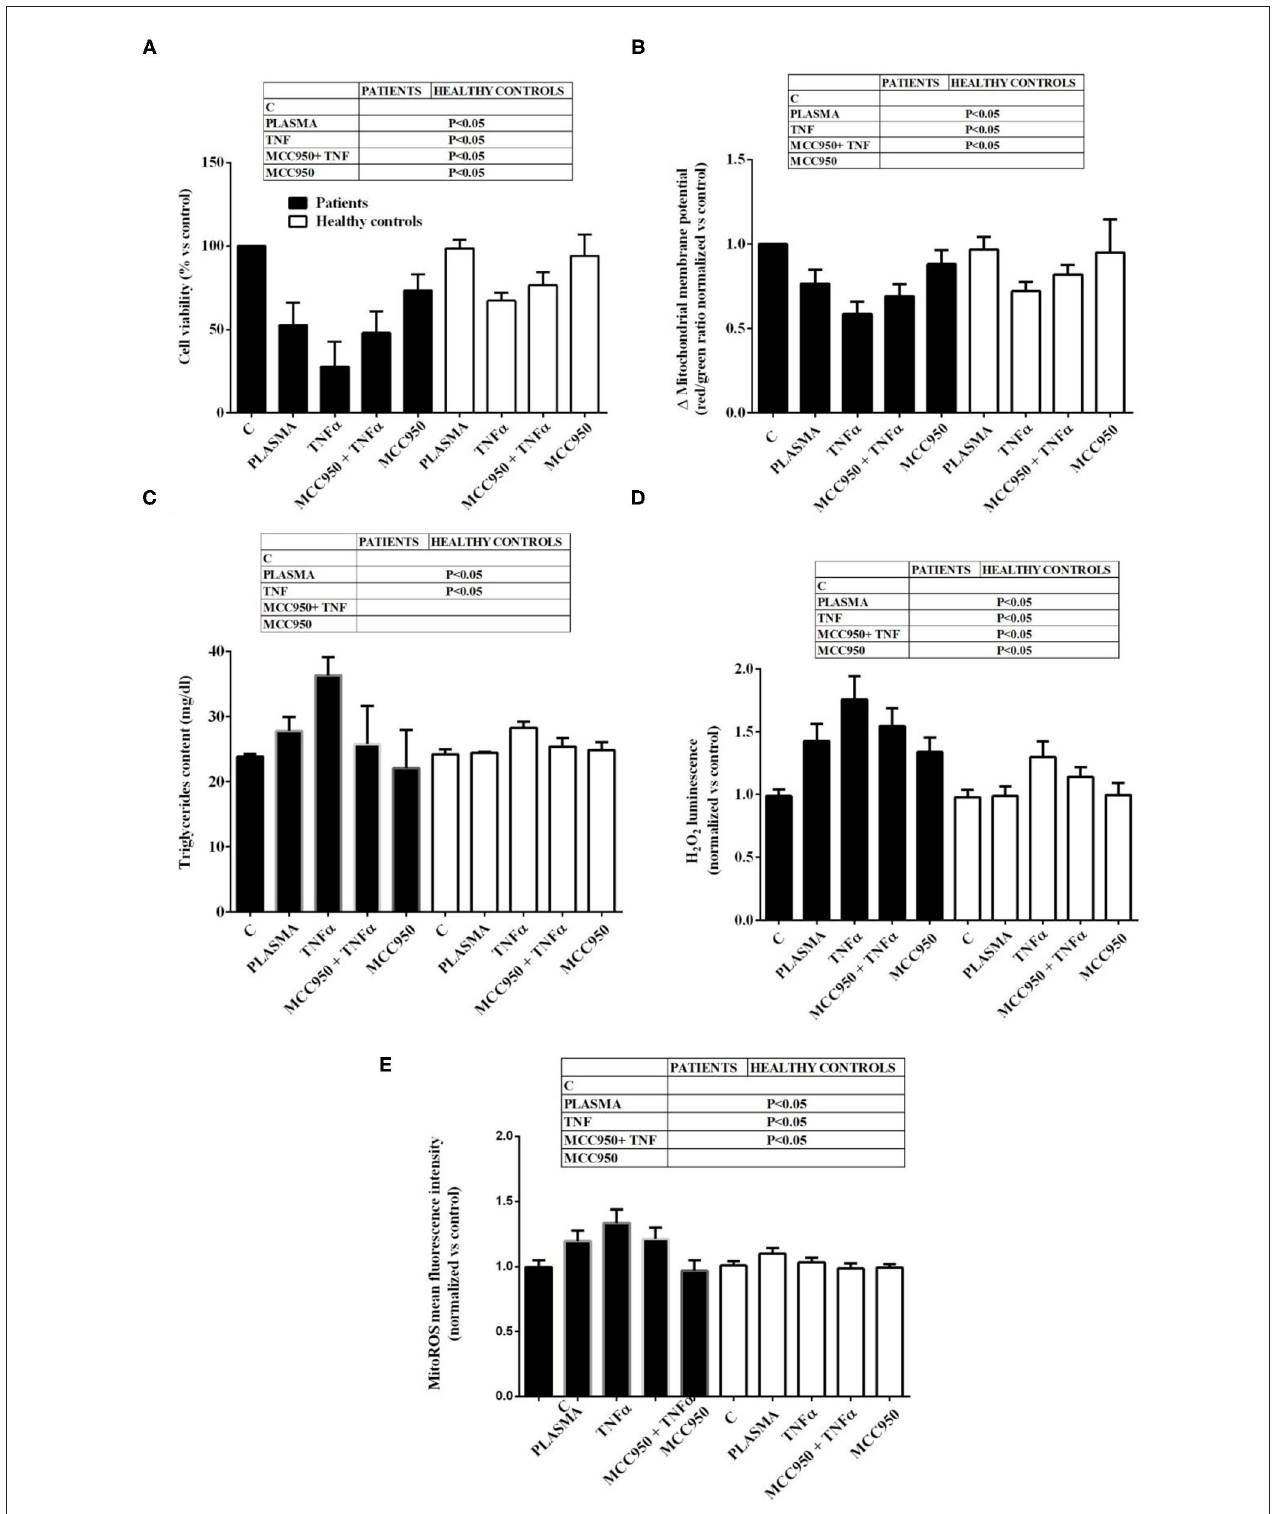
FIGURE 2 | Comparison between the effects of NAFLD plasma and of plasma from healthy subjects on Huh7.5 cell viability (A) , mitochondrial membrane potential (B) , triglycerides content (C) , H 2 O 2 release (D) and mitochondrial ROS (mitoROS, E ). Abbreviations are as described in Figure 1 . Reported data are means ± SD of five independent experiments for each experimental